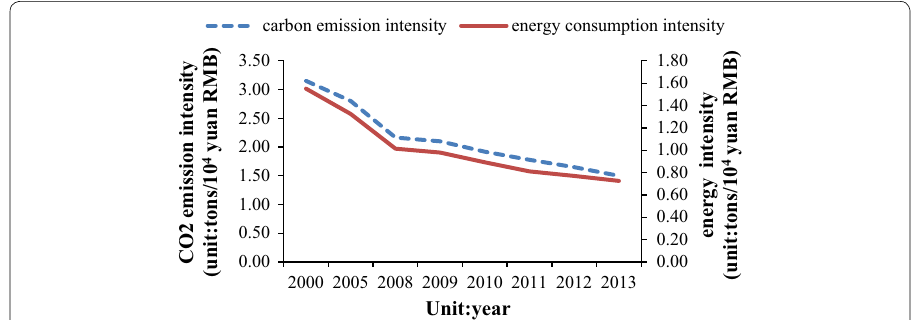
Fig. 1 The intensity of carbon emissions and energy consumption in China from 2000 to 2013